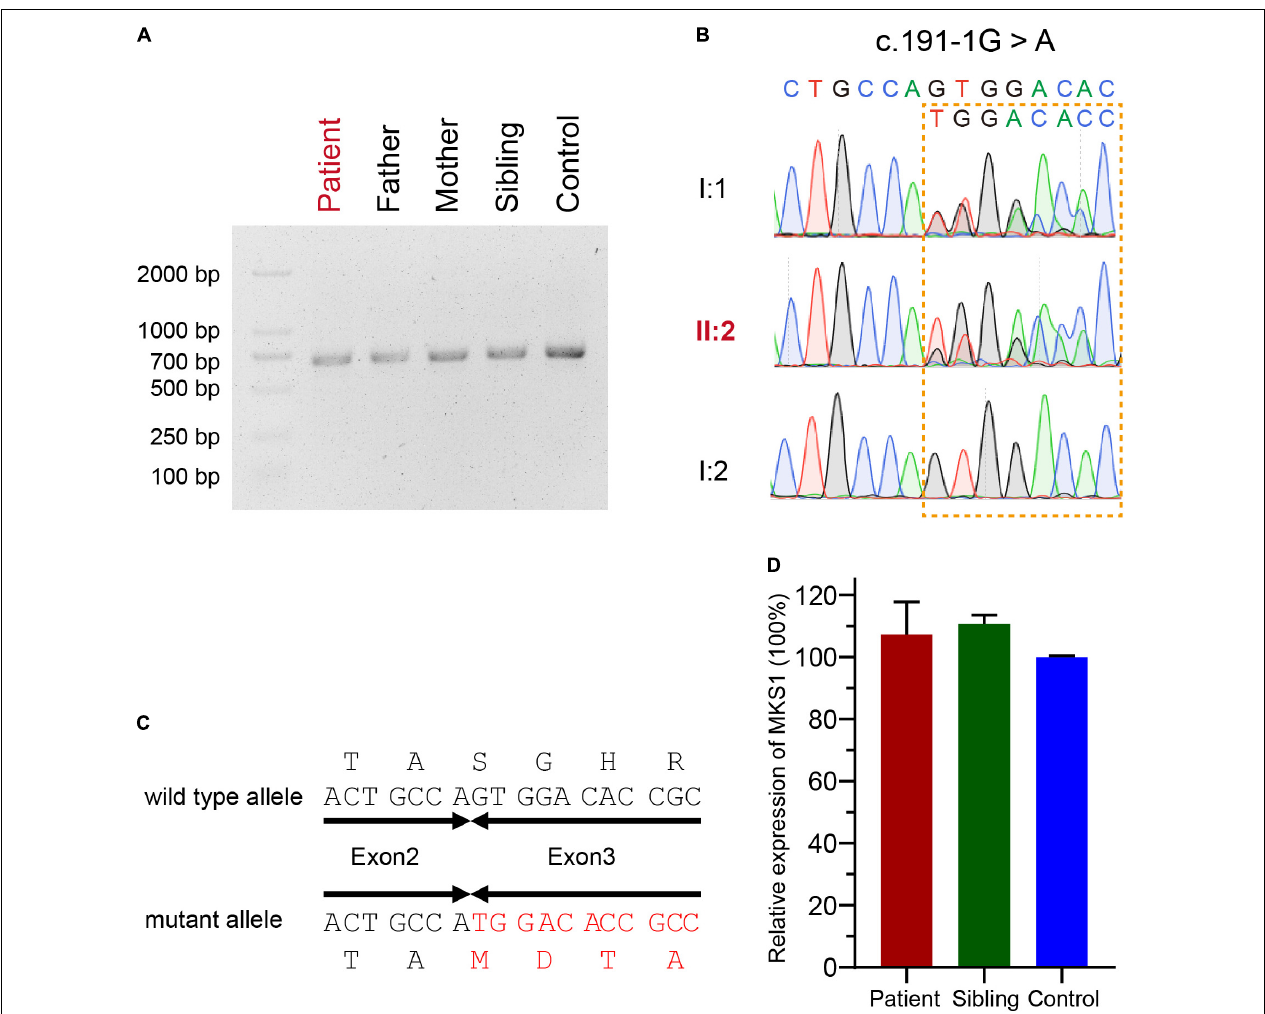
FIGURE 2 | Confirmation for an abnormal transcript of MKS1 . (A) Image of agarose gel electrophoresis of the PCR products from the proband, her parents, and sibling and the healthy control. (B) Chromatograms showing the DNA sequences of wild type and c.191-1G > A mutation. (C) The predicted protein sequences translated from mRNAs of wild type and c.191-1G > A mutation. (D) Relative MKS1 mRNA levels of the patient, the sibling, and a health control. Data from three independent experiments was used for the quantification. Error bars represent the SD.